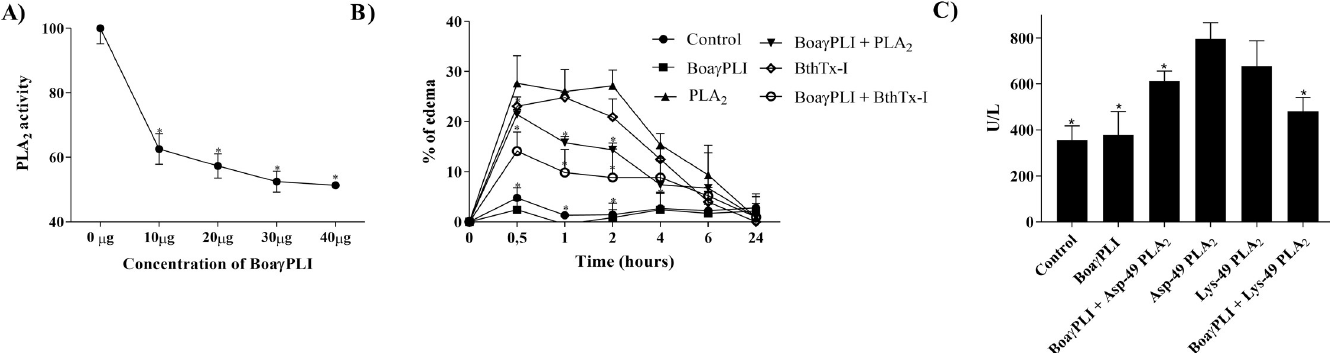
Fig 4. Inhibitory potential of the Boa γ PLI. A) Enzymatic activity of Asp-49 PLA 2 incubated with different concentrations (0 μ g, 10 μ g; 20 μ g and 40 μ g) of Boa γ PLI with NOB as a substrate. � represents statistical differences when compared to 0 μ g of inhibitor. B) Edematogenic activity of Asp-49 and Lys-49 PLA 2 isolated and when previously incubated for 30 min with 20 μ g of Boa γ PLI, injected into the right sub plantar region of mice paw (Swiss). C) Myotoxic activity of Asp-49 and Lys-49 PLA 2 isolated and when previously incubated for 30 min with 20 μ g of Boa γ PLI, injected in the gastrocnemius muscle of mice (Swiss). � represents statistical differences when compared to PLA 2